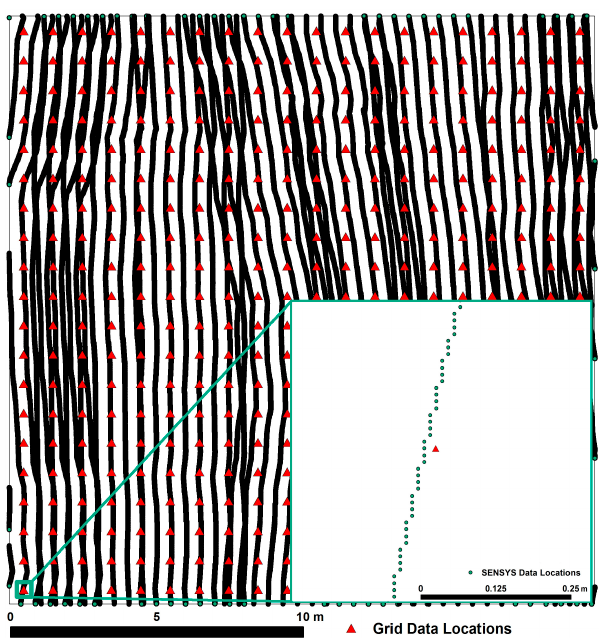
Figure 5. The grid collection of geomagnetic data (red triangles) results in far fewer data points than multi-sensor collection. The comparison is the most clear in the figure inlay. For both images, the north is up.